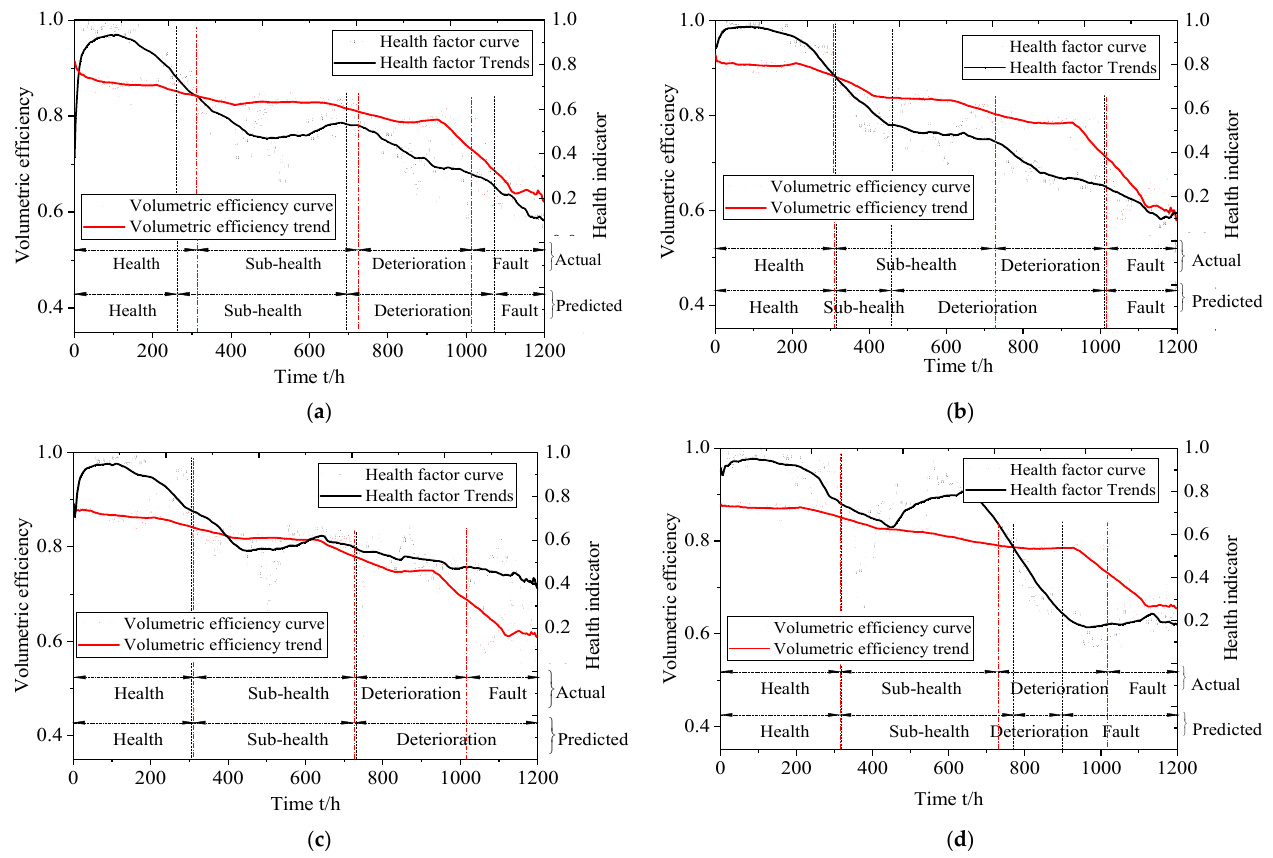
Figure 16. The actual health status and its predicted health status of gear pumps: ( a ) gear pump 1; ( b ) gear pump 2; ( c ) gear pump 3; and ( d ) gear pump 4.